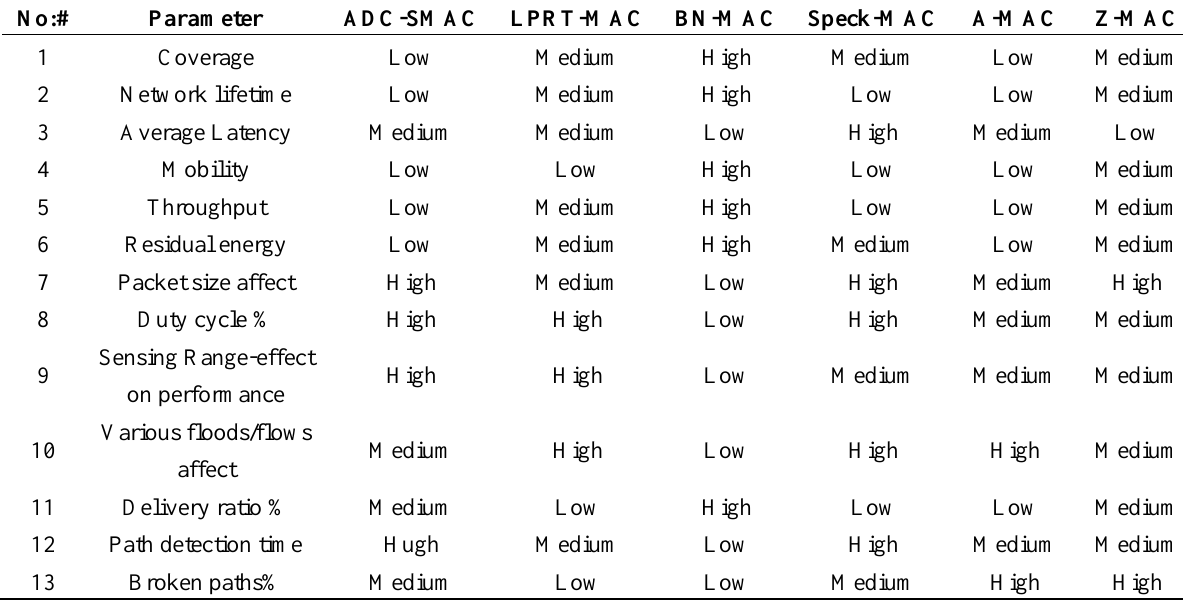
Table 4. Characteristics and affecting factors of Hybrid Medium Access Control (MAC) Protocols and BN-MAC